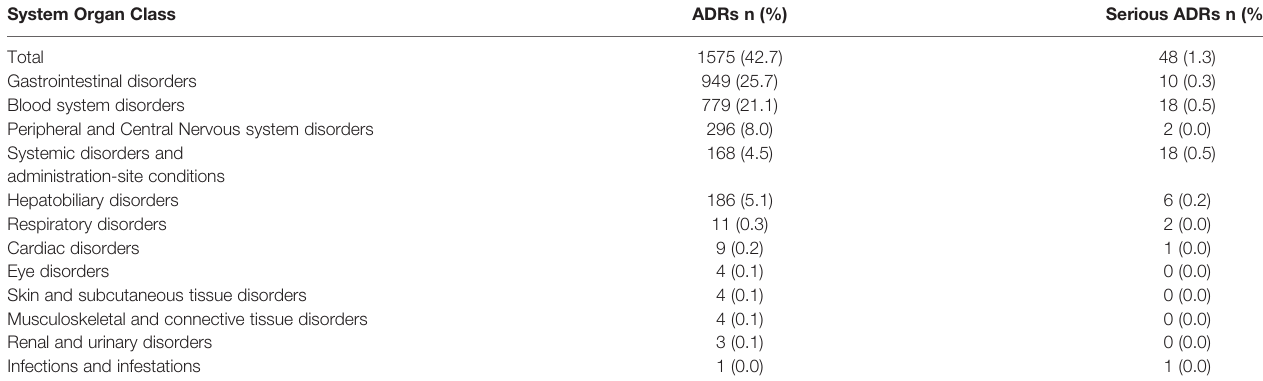
TABLE 2 | Incidence of ADRs and serious ADRs in patients receiving OXA (N = 3687).